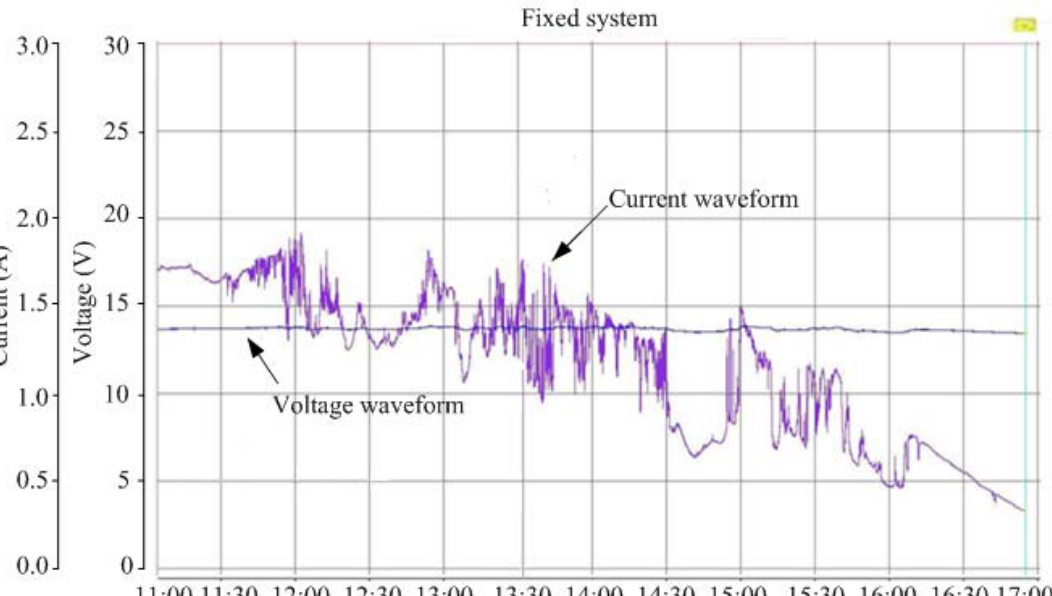
Figure 9. Measured time functions of output voltage and current for fixed PV